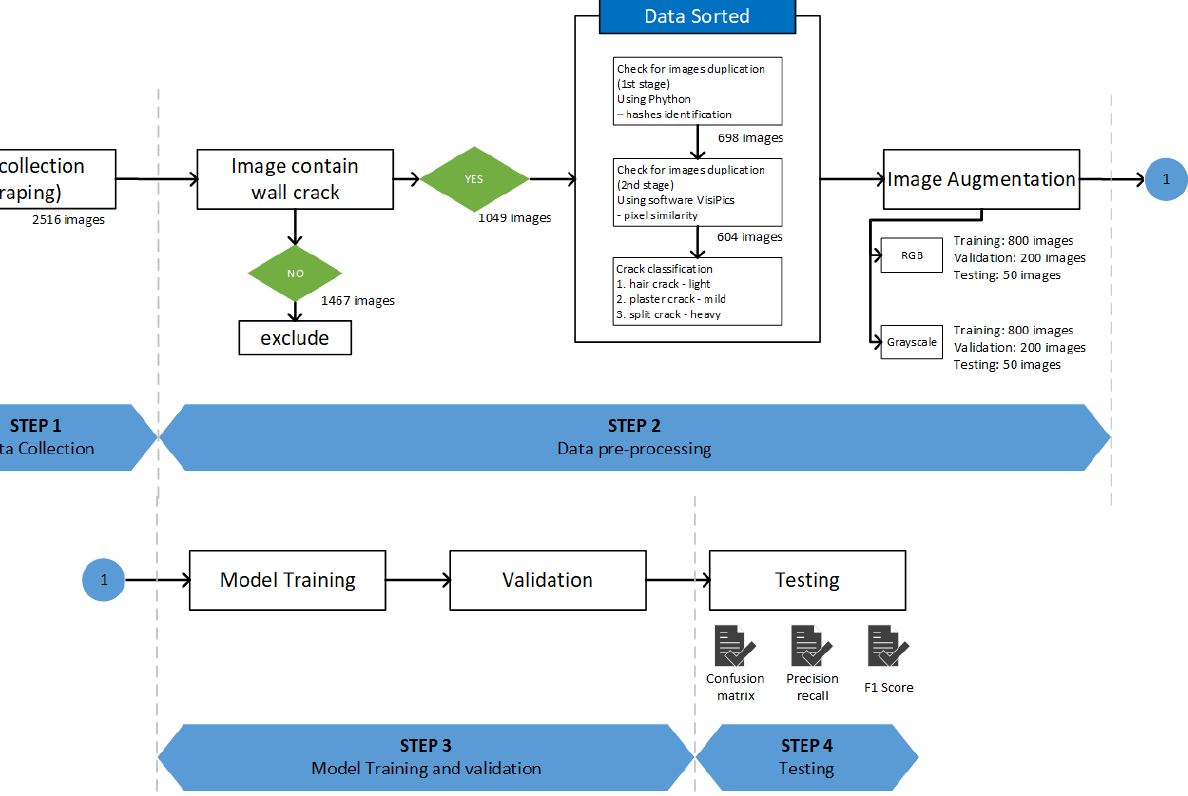
Figure 2. A general overview of the